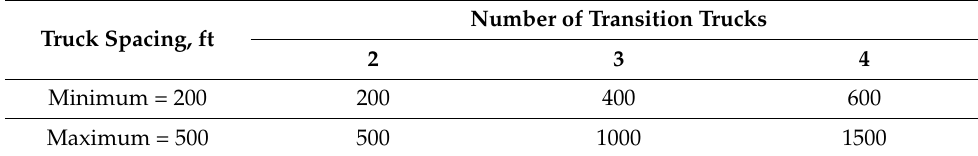
Table 11. Number of transition trucks, with spacings in feet